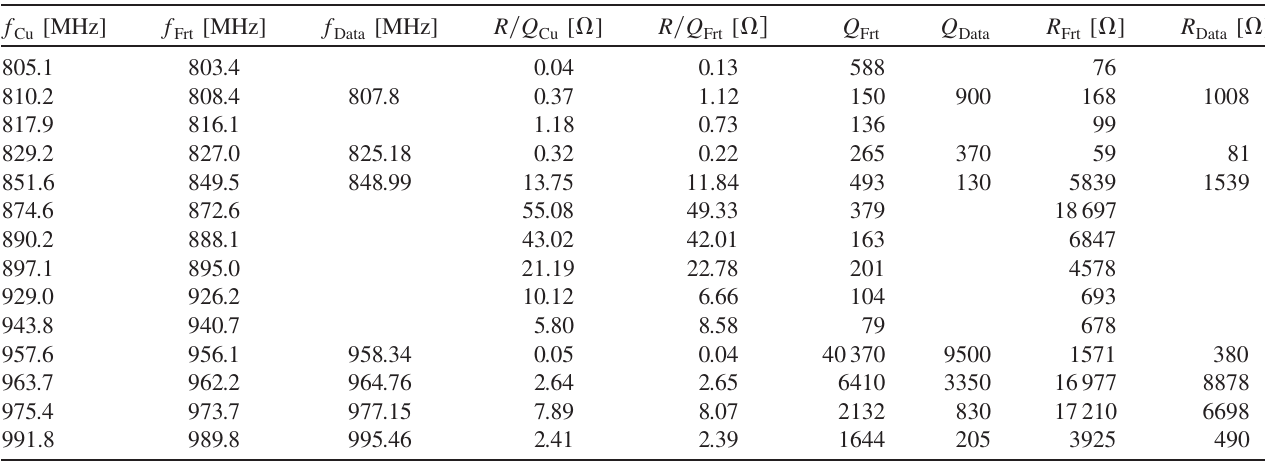
TABLE V. Dipole resonances in the ERL cavity.